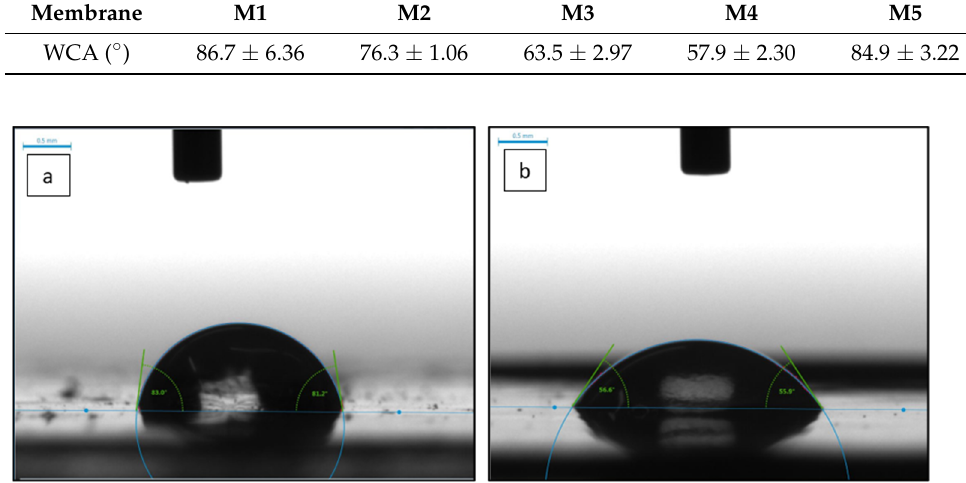
Table 2. Water contact angle (WCA) of the membranes.